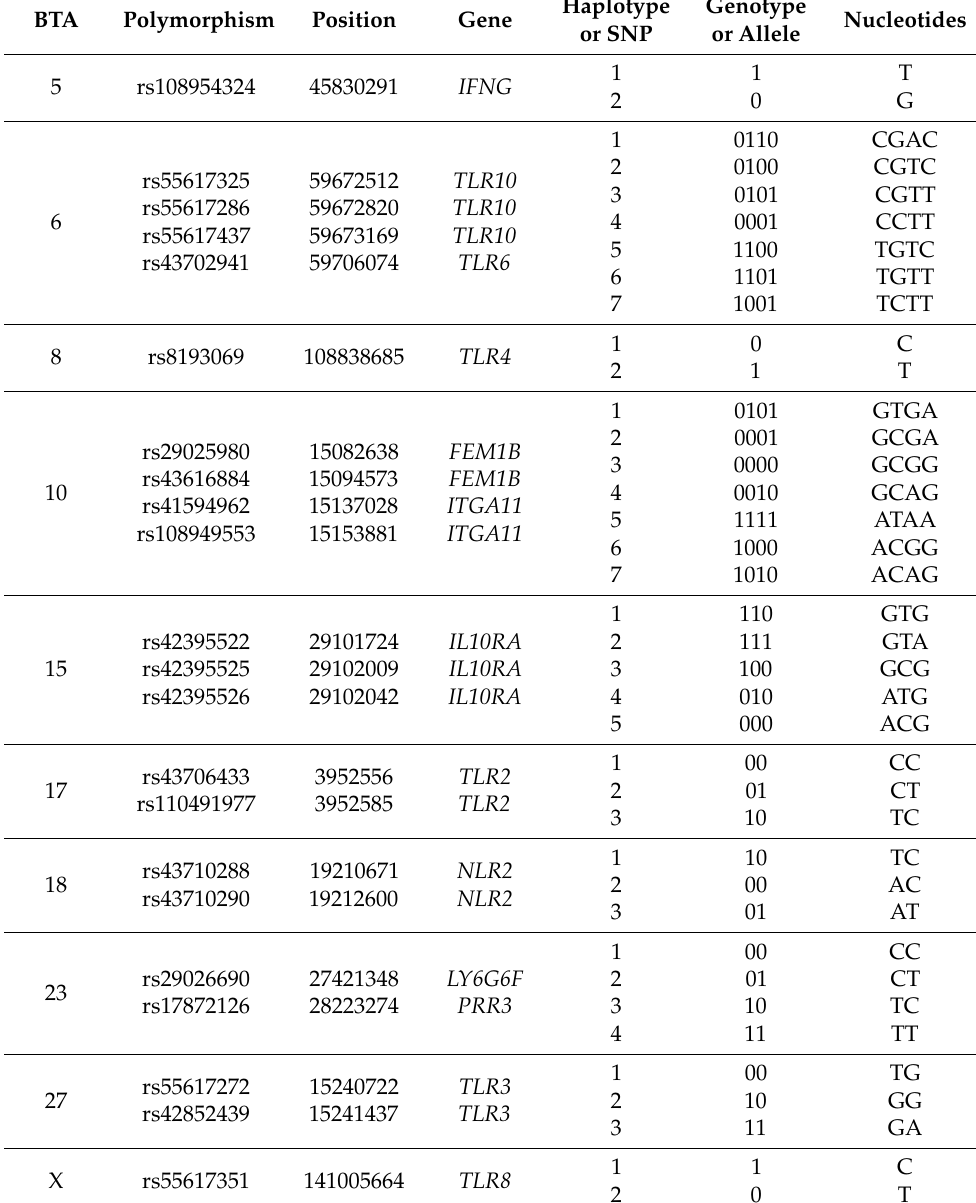
Table 3. Haplotypes and SNPs related to the immune response in Curraleiro P é -Duro